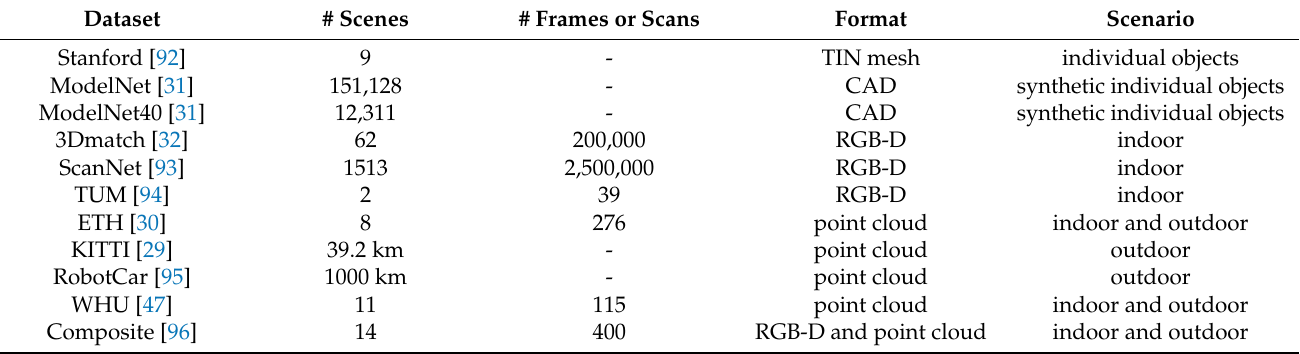
Table 1. Summary of some widely used benchmark datasets for point cloud